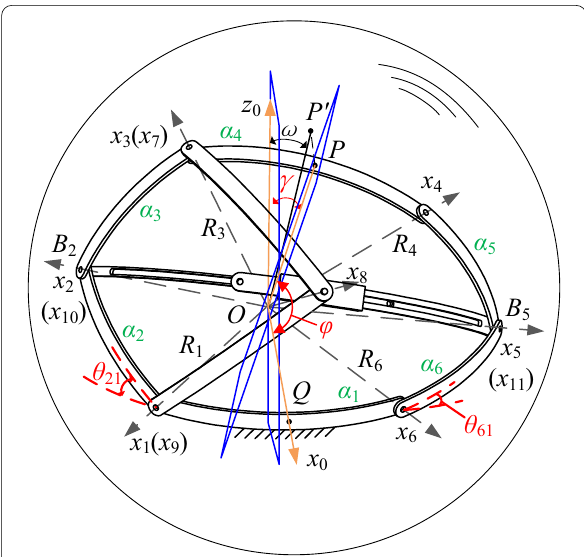
Figure 2 Kinematic model and parameter representation of the 2-DOF SPM